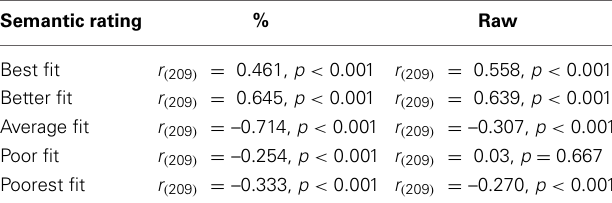
Table 1 | Pearson correlation between semantic rating and